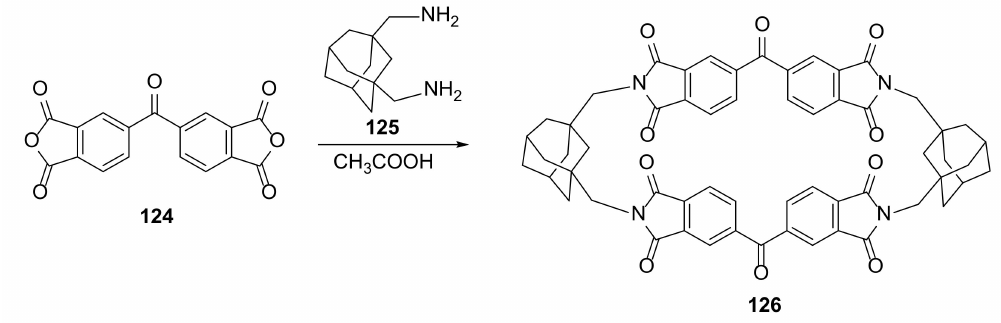
Figure 22. Synthesis of 2 + 2 macrocycle 126 having benzophenone-3,3 (cid:48) ,4,4 (cid:48) -tetracarboxylic diimide and adamantane